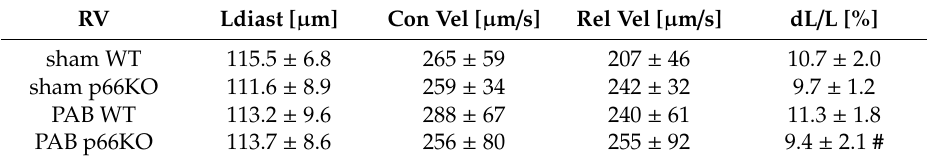
Table 1. Cell shortening of isolated right ventricular (RV) cardiomyocytes three weeks after pulmonary artery banding (PAB) or sham surgery. Data show the diastolic cell length (Ldiast in µ m), contraction velocity (Con Vel in µ m / s), relaxation velocity (Rel Vel in µ m / s) and load-free cell shortening (dL / L in %) of isolated RV myocytes. Data are given for wild type (WT) and p66shc knockout (p66KO) mice three weeks after sham surgery or PAB. Data are shown as means ± SD from 101 cells (WT sham), 153 cells (p66KO sham), 106 cells (WT PAB) and 131 cells (p66KO PAB), respectively (4 mice each group). #: p < 0.05 vs. WT PAB as analyzed by two-way ANOVA. RV Ldiast [ µ